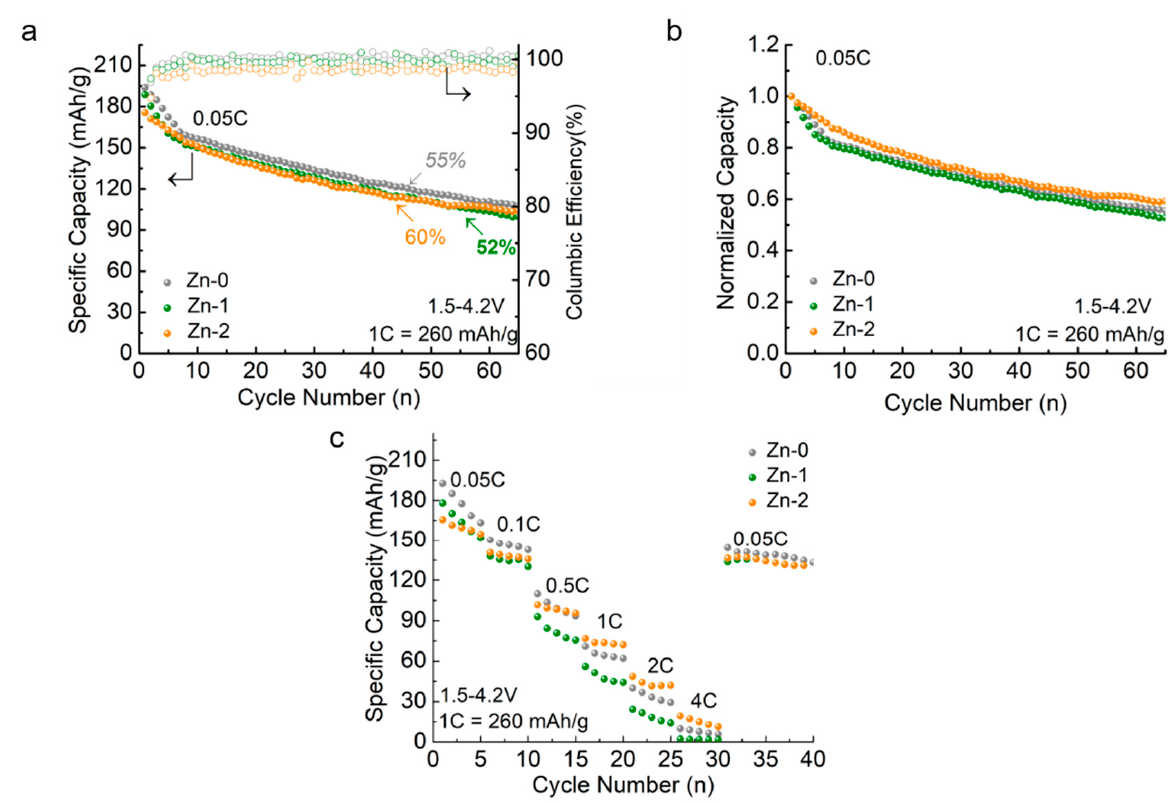
Figure 6. Electrochemical performances of Zn-0, Zn-1 and Zn-2 cathode cycled between 1.5–4.2 V vs. Na/Na + . ( a ) Cycling stability at 0.05 C (1 C = 260 mA g − 1 ). ( b ) Normalized capacity vs. cycle number. ( c ) Rate performances at different C-rate.